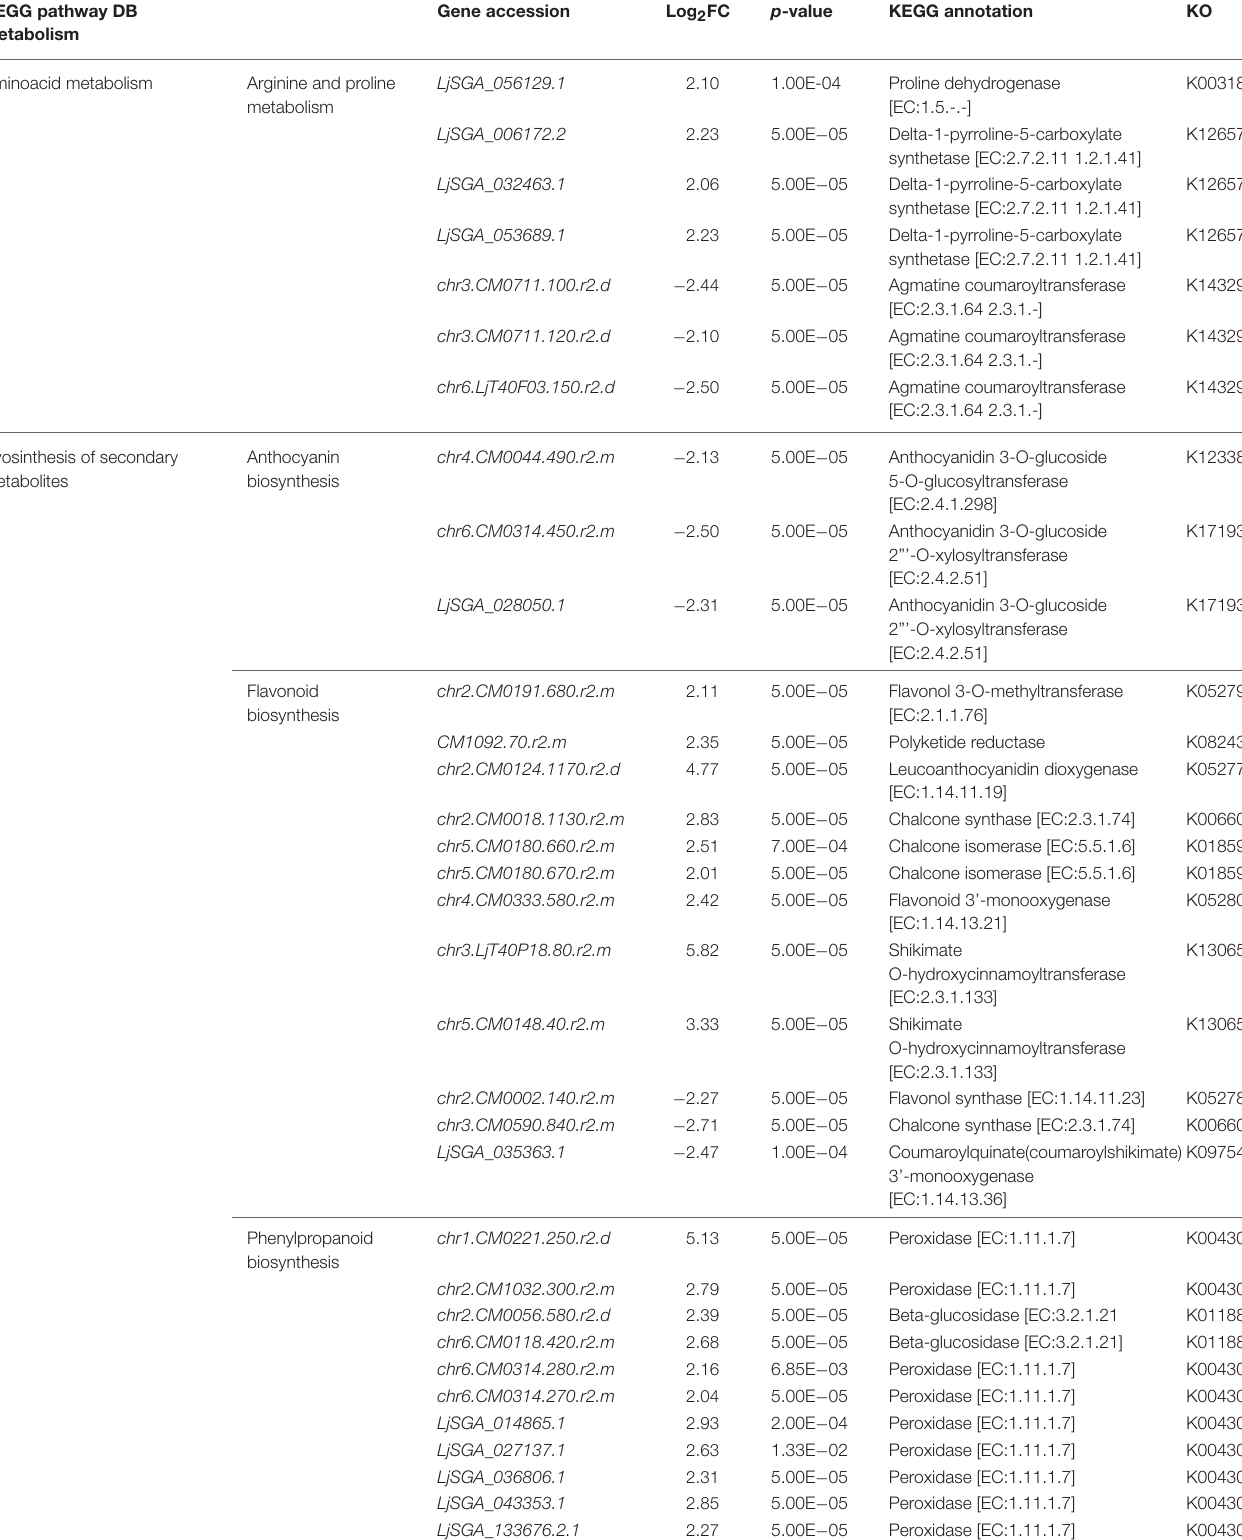
Gene accession Log 2 FC p -value KEGG annotation KO